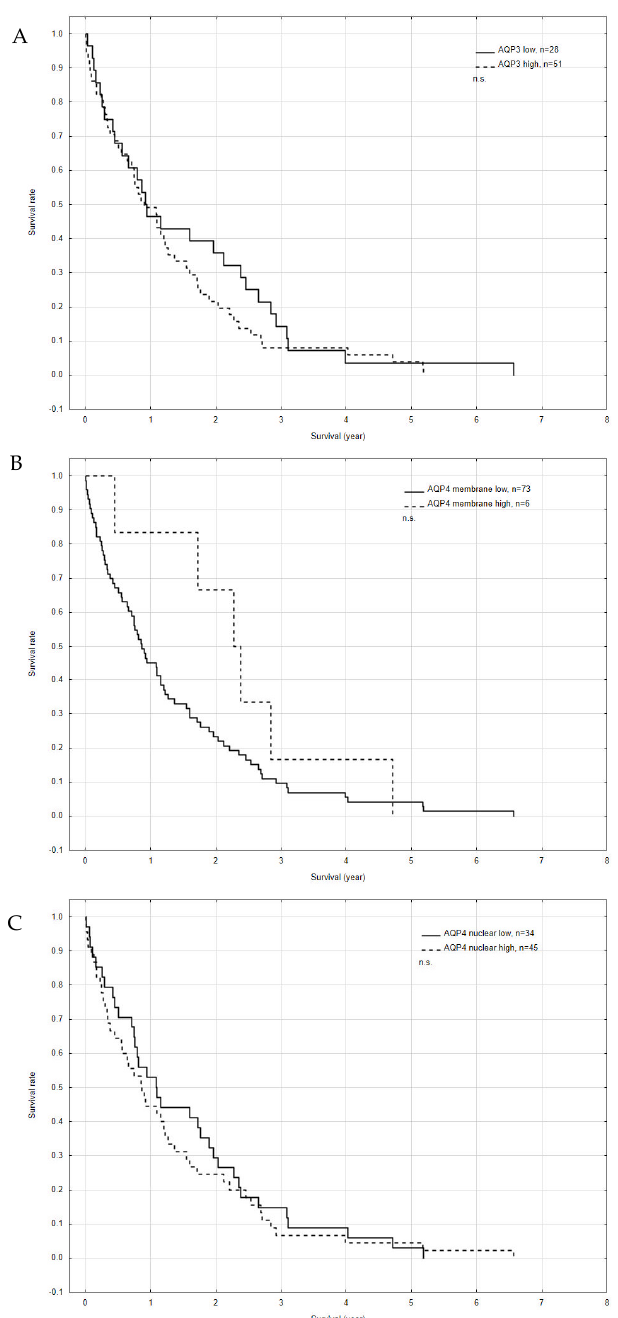
Figure 4. Kaplan–Meier survival curves for overall survival (OS) according to the expression of aquaporin 3 (AQP3) ( A ); aquaporin 4 (AQP4) membrane expression ( B ); and AQP4 nuclear expression ( C ). n.s.—no significance.